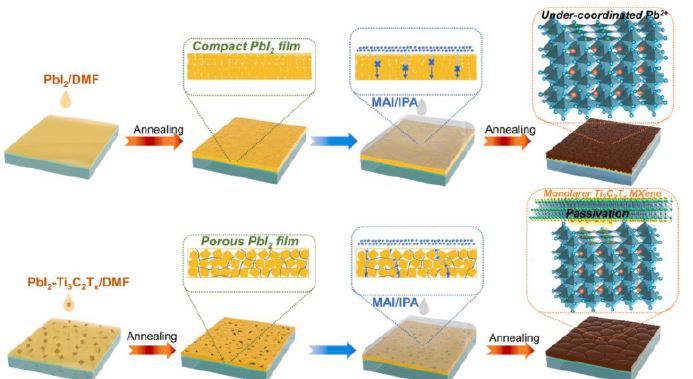
Figure 2. Mechanism diagram for the production of high-quality perovskite films processed in two steps, supported by the additive Ti 3 C 2 T x . Reprinted with permission from ref. [100]. Copyright 2020 Elsevier B.V.